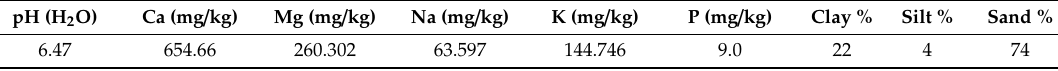
Table 2. Soil chemical and physical properties in Bale Village before